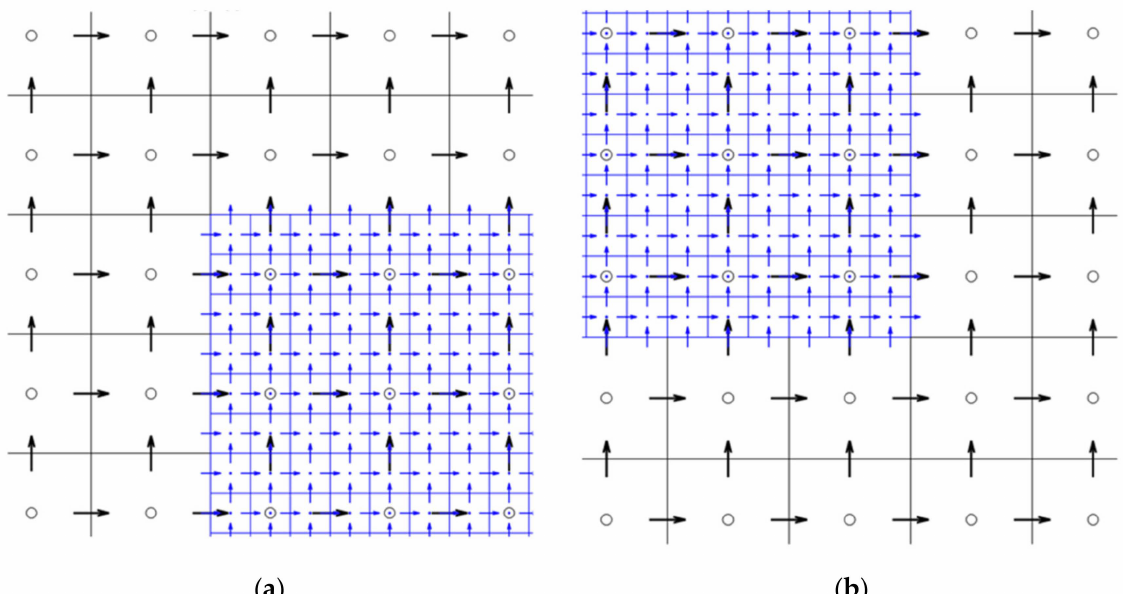
Figure 1. Sketch of a nested-grid domain in the grid size ratio of 3:1 ( a ) at the upper left corner of a fine grid; ( b ) at the lower right corner of a fine grid. Circles indicate the free surface elevations (black–the coarse grid; blue–the fine grid). Arrows show the volume-flux components of the x - and y -directions (black–the coarse grid; blue–the fine